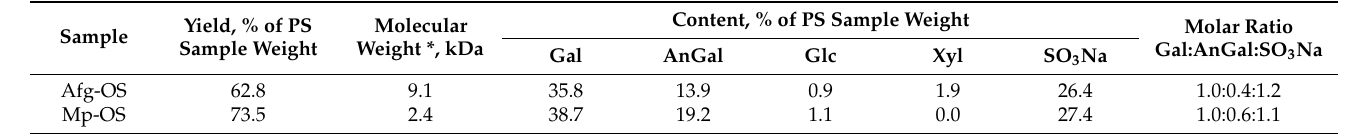
Table 4. Yields and chemical analysis of oligosaccharides (OSs) from Afg and